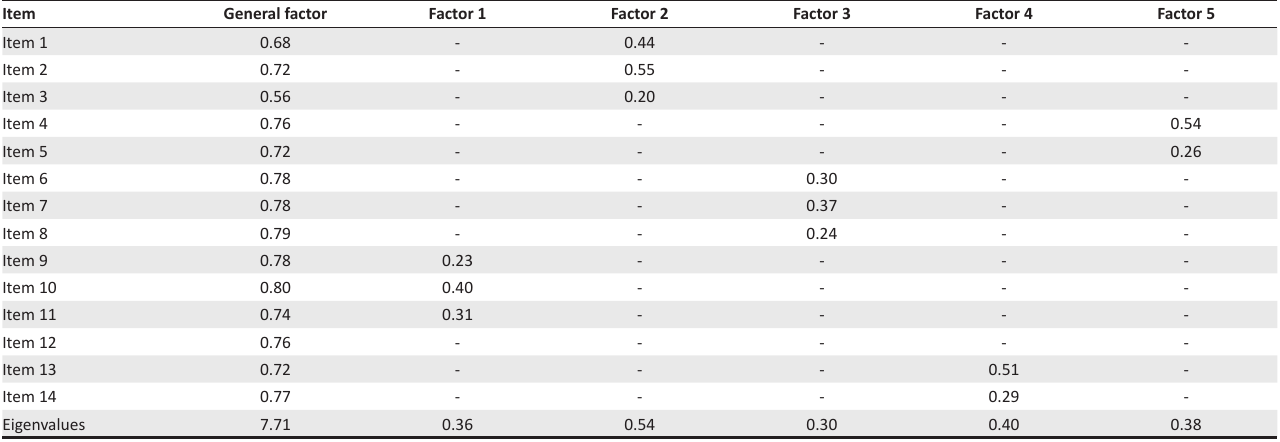
TABLE 4: Schmid–Leiman